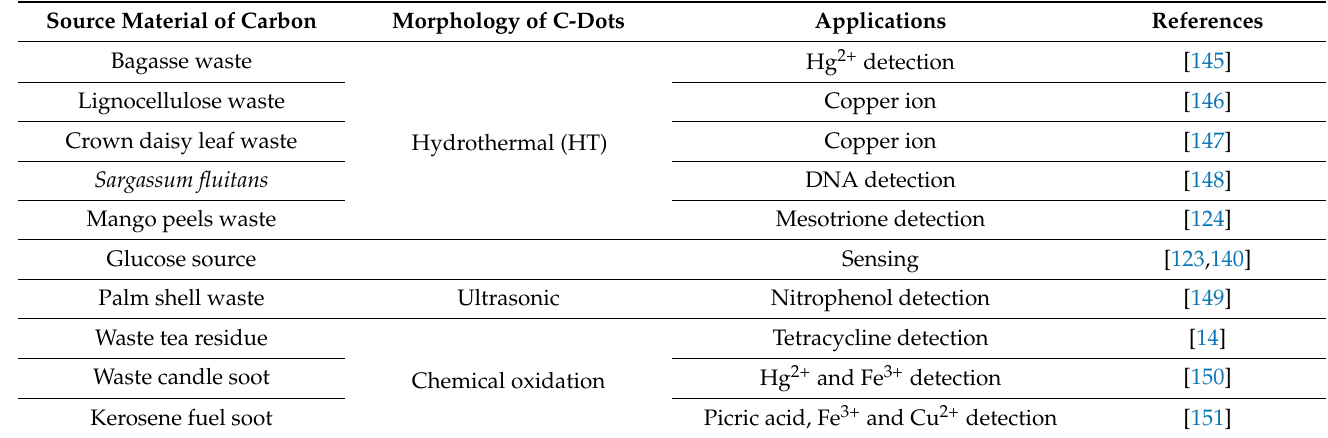
Table 11. Applications of C-dots in the sensing